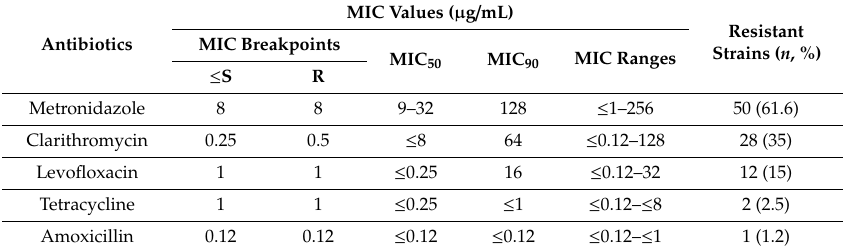
Table 1. MIC 50 and MIC 90 values through the E-test method for the 80 Helicobacter pylori strains.